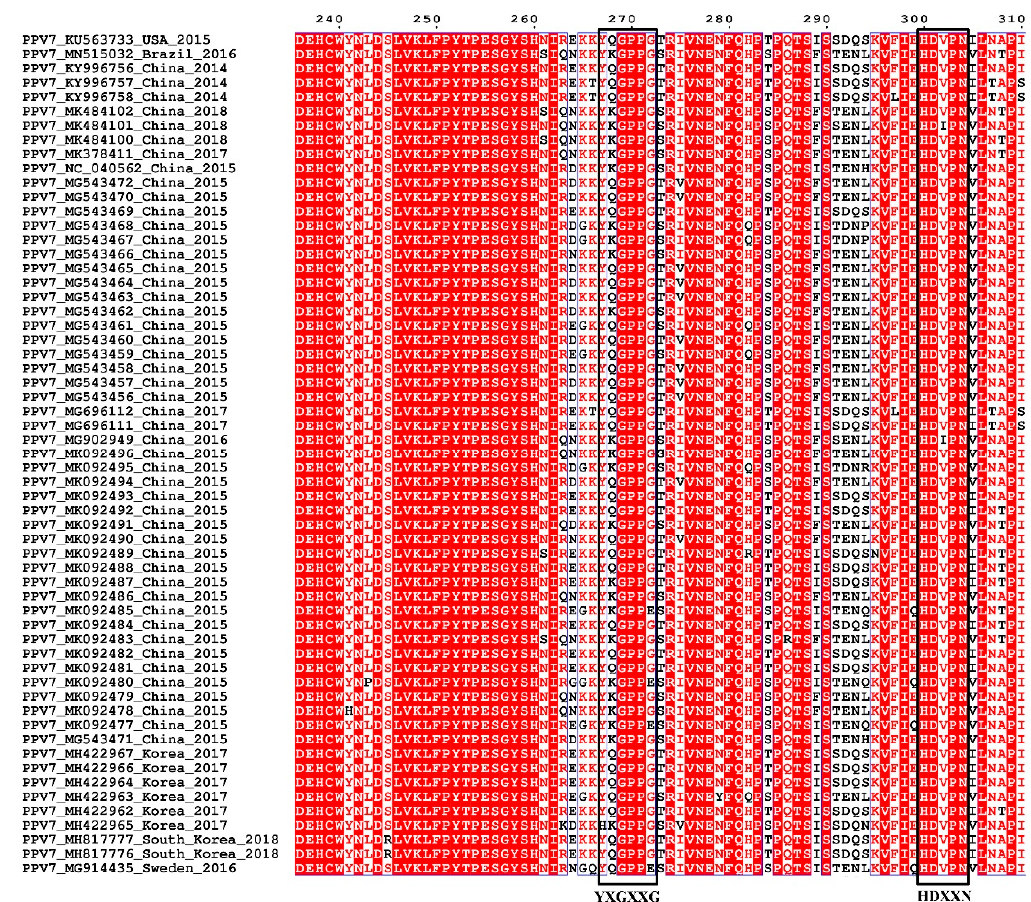
Figure 3. Sequence alignment of Ca 2 + binding loop and putative secretory phospholipase A2 (PLA2) motif of PPV7. The conserved amino acids of the Ca 2 + binding loop ( 267 YXGXXG 272 ) and the catalytic residues ( 300 HDXXN 304 ) are indicated at the bottom of the alignment.